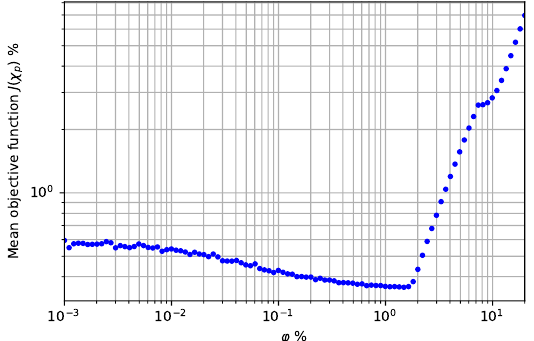
Figure 12. Behavior of the objective function for different values of ϕ . The KC200GT SPVM is